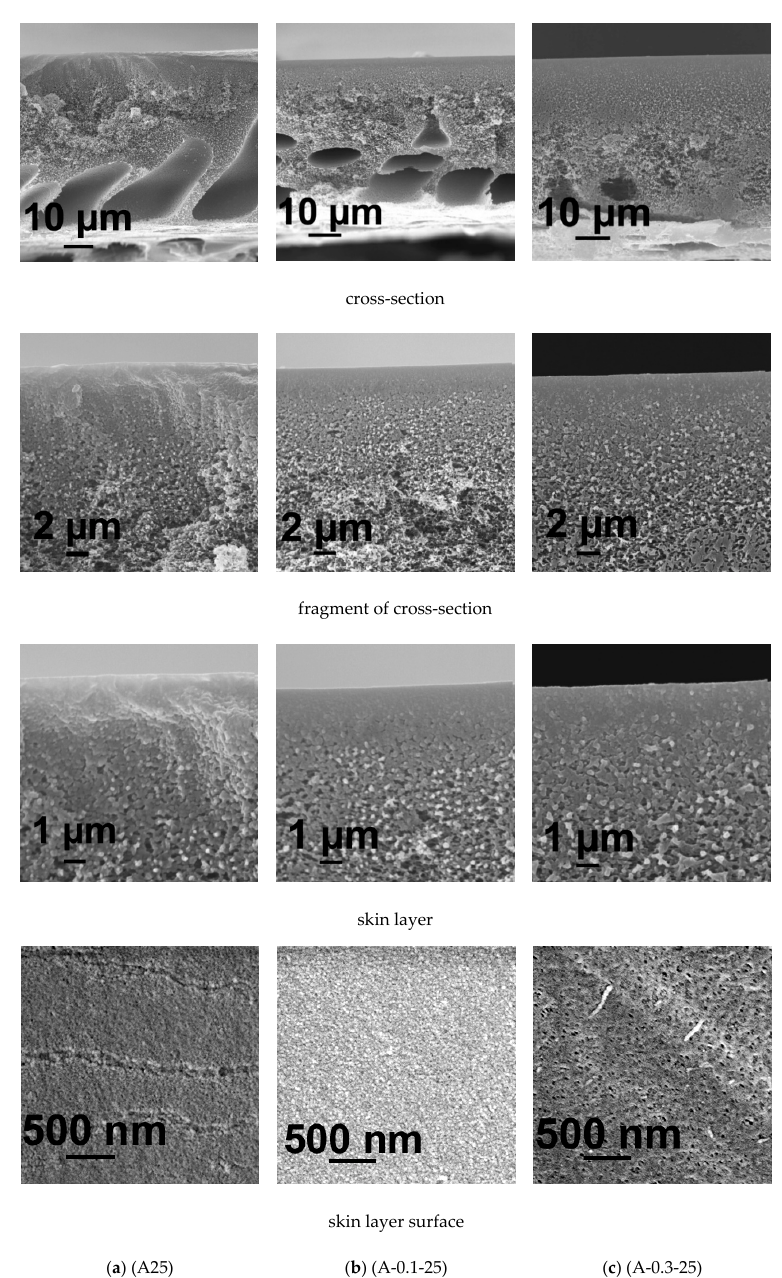
Figure 5. SEM micrographs of the membrane cross-section, enlarged fragment of the cross-section, skin layer and surface of the skin layer, coagulation bath, T = 25 °C, PASA concentration in the coagulant, wt %: ( a ) 0; ( b ) 0.1; ( c ) 0.3.